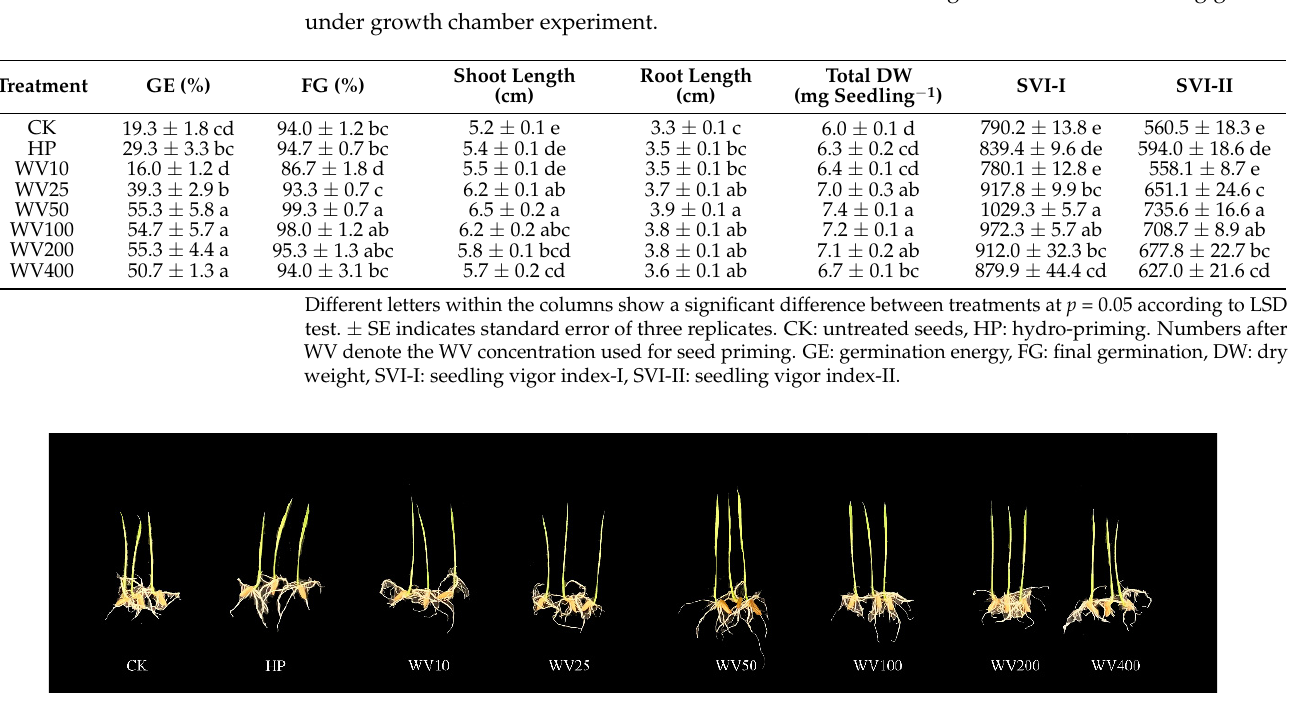
Table 1. Effect of different concentrations of WV on WDR seed germination and seedling growth under growth chamber experiment.